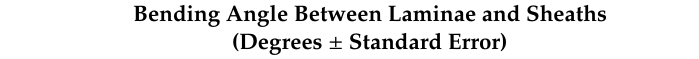
Table 1. E ff ect of BR 24-norcholane type analogs and epimeric mixtures of 3 / 4 on lamina inclination of rice seedlings. Brassinolide was used as positive control.